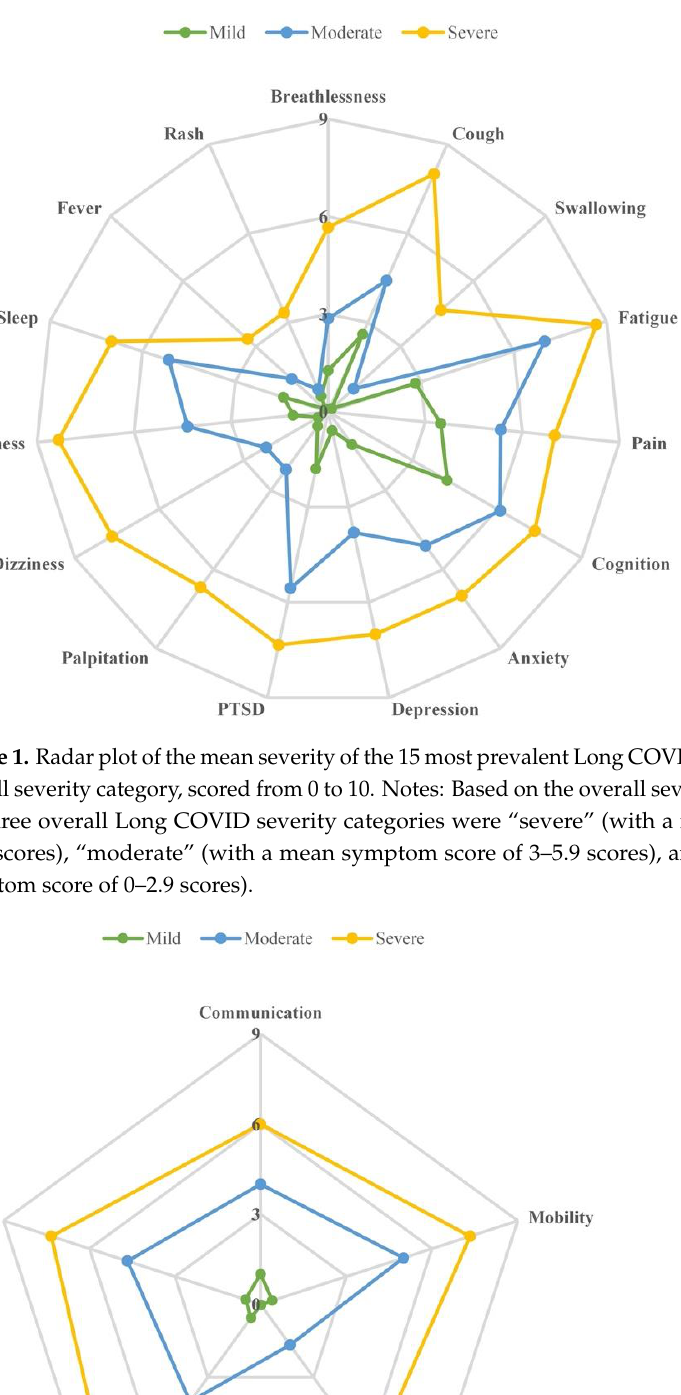
Figure 2. Radar plot of the mean severity of five Long COVID-related functional difficulties within each overall severity category, scored from 0 to 10.